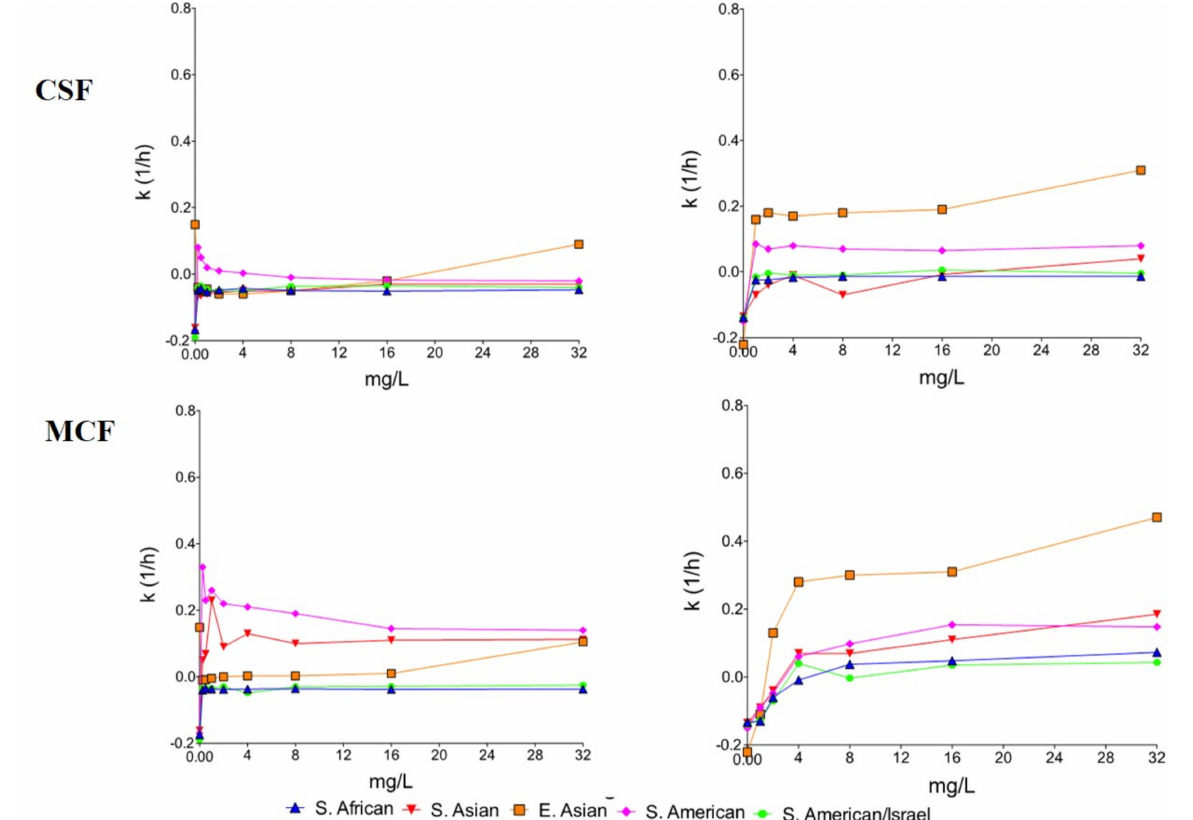
Figure 2. Mean killing rate values of rezafungin (RZF), anidulafungin (ANF), caspofungin (CSF), and micafungin (MCF) in RPMI-1640 (RPMI) and RPMI-1640 plus 50% human serum (50% serum) against 4 Candida auris clades. Data of the type strain (NCPF 13029 = CBS 10913) were not included in the East Asian clade. Positive and negative k values indicate the decrease and increase, respectively, in viable cell numbers. Error bars were omitted for better visualization of the